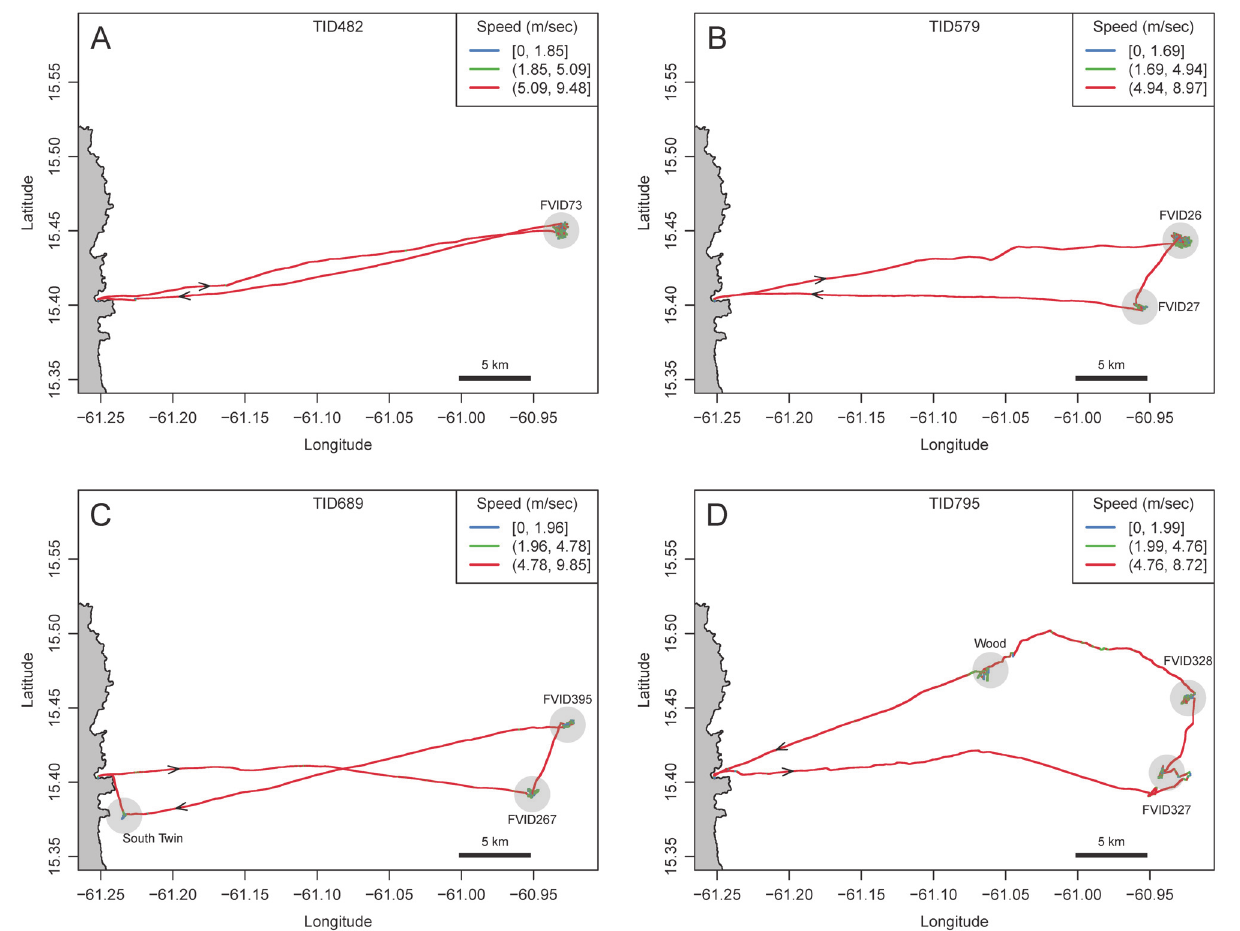
Fig 2. Four example GPS tracks of foraging Dominican FAD fishers. The east coast of Dominica is indicated on the left of each plot. Trips originate at Desa Ikan and travel eastward toward the FADs. Track points are colored to indicate speed. (A) Trip to one FAD. (B) Trip to two FADs (C) Trip to a FAD and a near shore shallow water FAD. (D) Trip to two FADs and a wood . Each track is identified by a Trip ID number (TID). Arrows indicate direction of travel. Transparent blue circles indicate areas that were identified as patches by the observer and subsequently identified as ARS. See Fig. 5 for a higher resolution plot of tracks at